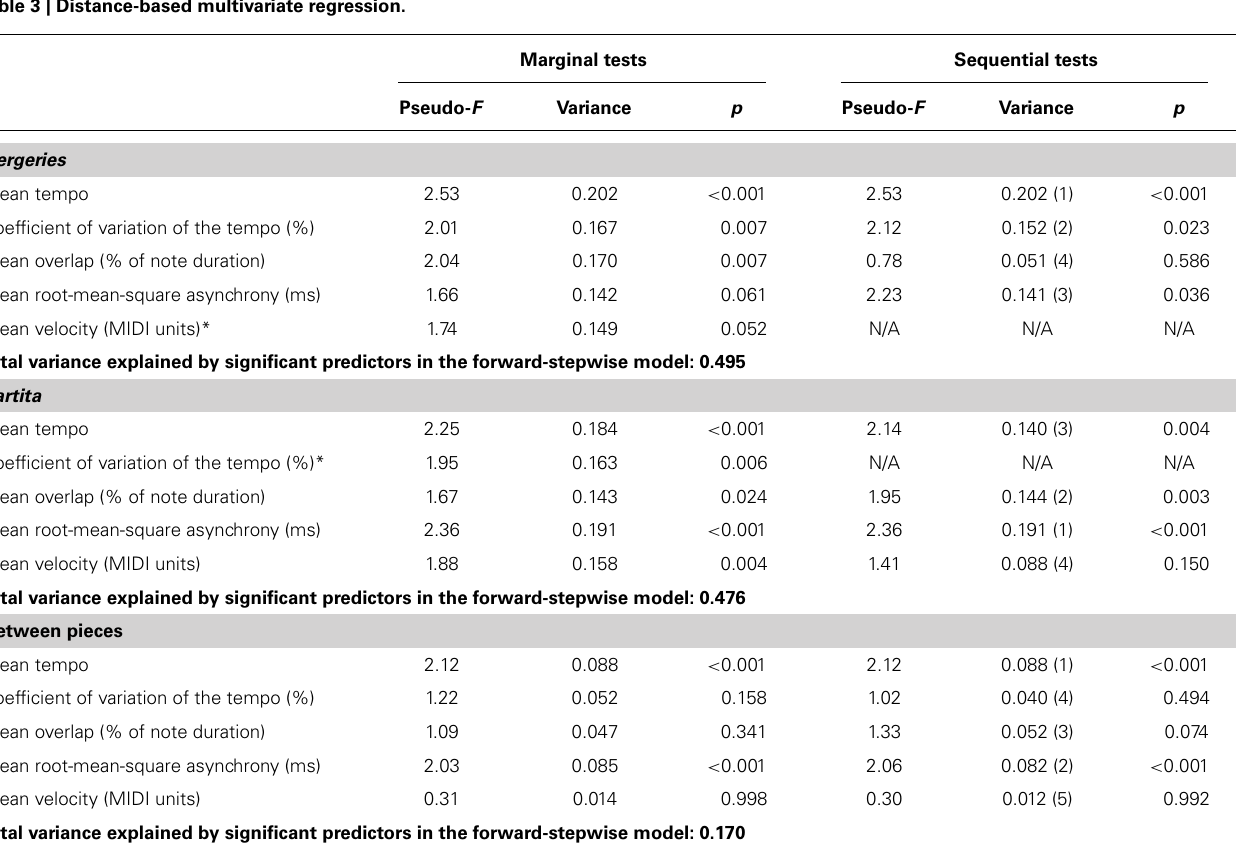
Table 3 | Distance-based multivariate